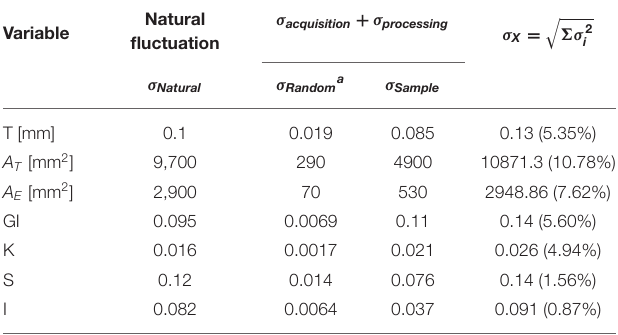
TABLE 2 | Summary of the estimated uncertainty components for each morphological variable of interest.